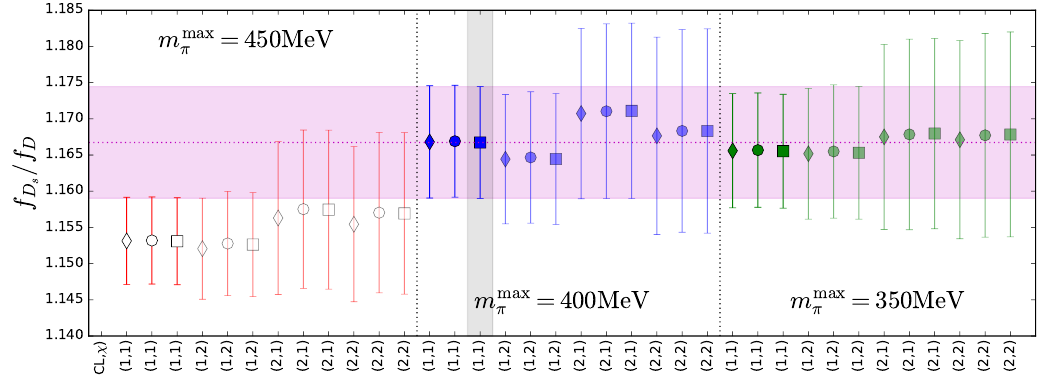
Figure 10 . Comparison of the results of the di(cid:11)erent choices in the global (cid:12)t. The grey and magenta bands highlight the (cid:12)t shown in (cid:12)gure 9. The di(cid:11)erent symbols indicate di(cid:11)erent ways of (cid:12)xing the heavy quark mass, i.e. H = D ( ) ; D s ( ) ; and (the connected part of) (cid:17) c ( (cid:3) ). Fainter data points indicate that at least one of the heavy mass dependent coe(cid:14)cients is compatible with 3 # zero at the one sigma level. More detail about the data shown here is given in the